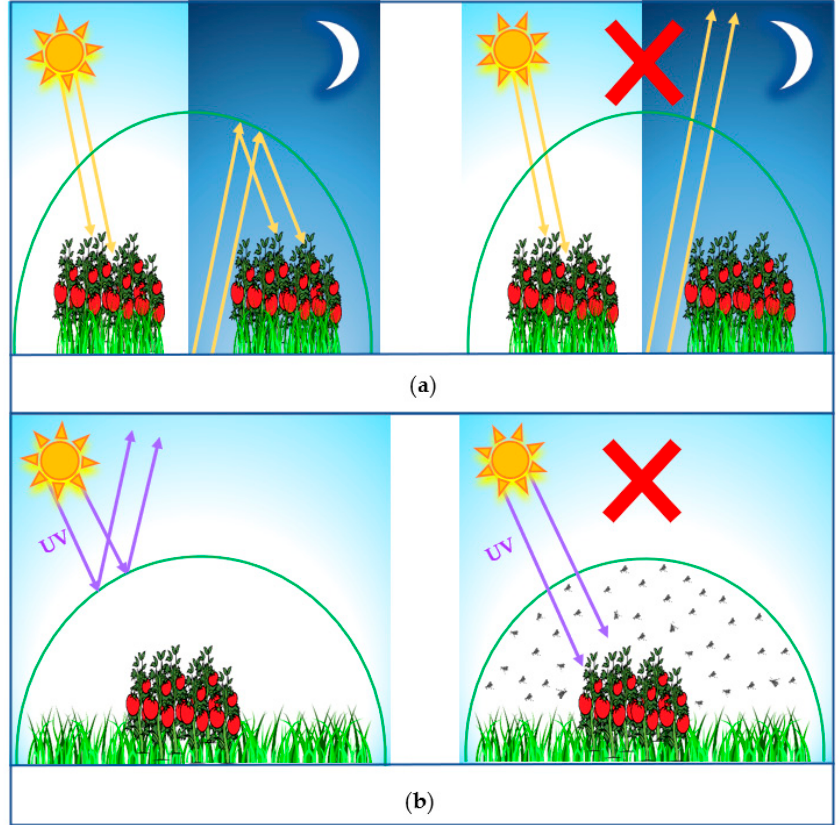
Figure 1. The new features of the suggested photoselective PMMA greenhouse films doped with perylene dyes KREMER 94720 and KREMER 94739. ( a ) Thermic effect. ( b ) UV-blocking effect.